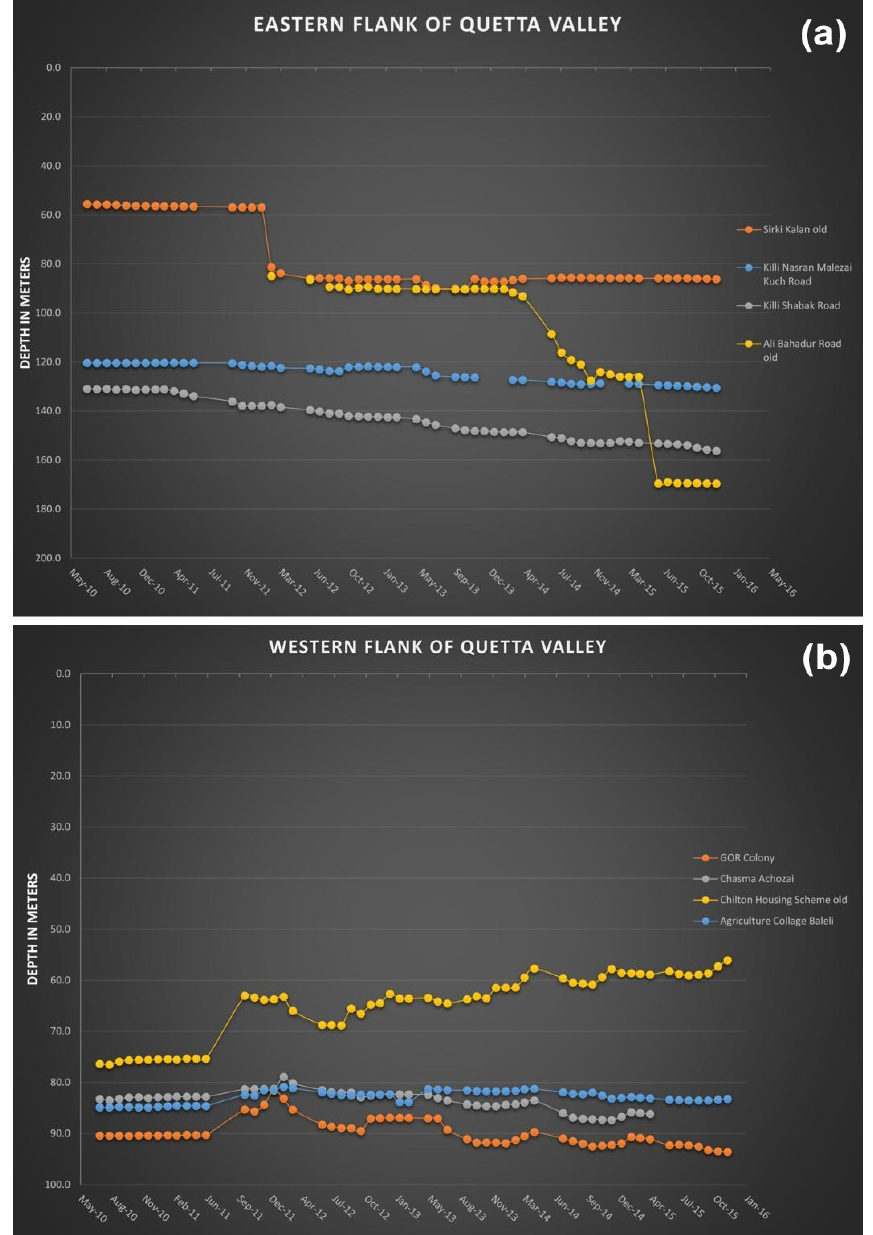
Figure 6. (a) Graph of water decline on eastern flank of Quetta valley. The average decline recorded in this zone is 1.5–5.0myr − 1 . (b) Graph of water decline on western flank of Quetta valley. The average decline recorded in this zone is 0.5–1.5myr − 1 . The observation well in Chilton housing Scheme shows rise in water